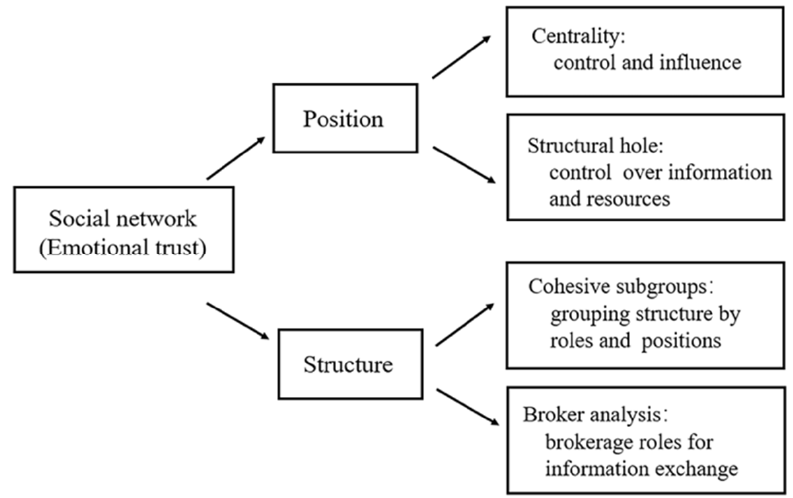
Figure 1. The structural dimension of social capital.